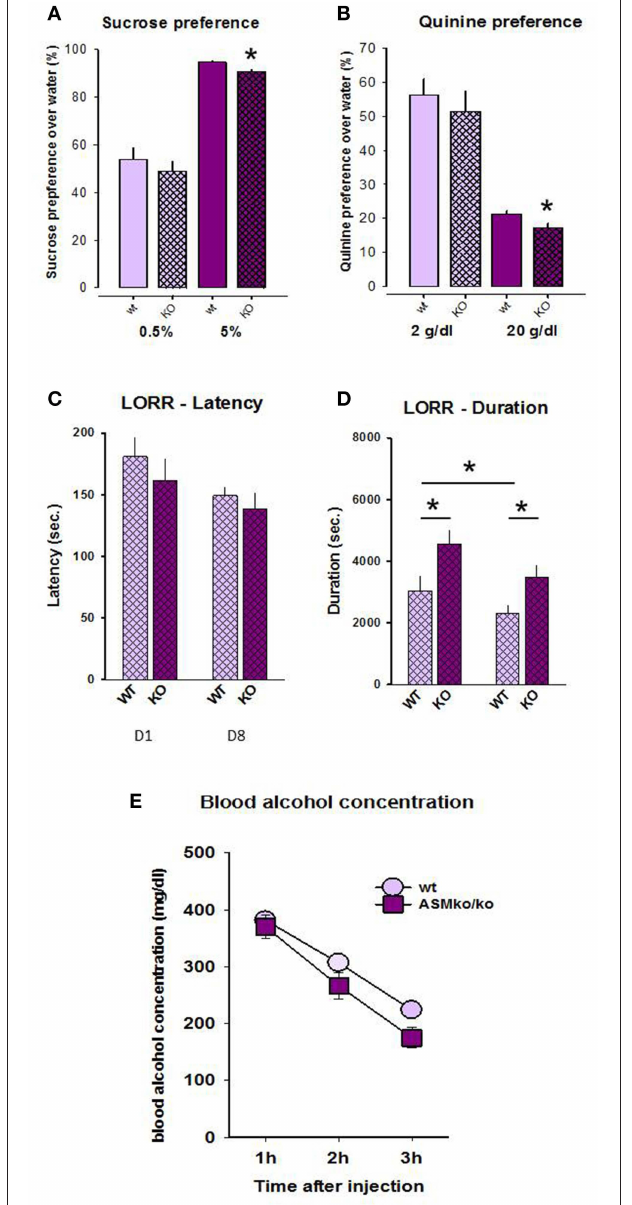
FIGURE 2 | Sucrose (A) and quinine (B) preference is lower in mice with acid sphingomyelinase deficiency (KO) compared to wt littermates. The duration (D) , but not the latency (C) of loss of righting reflex is significantly higher in mice with acid sphingomyelinase deficiency both at day 1 and 8 of alcohol treatment. Blood alcohol concentration (E) does not significantly differ between mice with acid sphingomyelinase deficiency and wt mice. The error bars show the mean ± SEM (* p < 0.05 vs. wt animals).